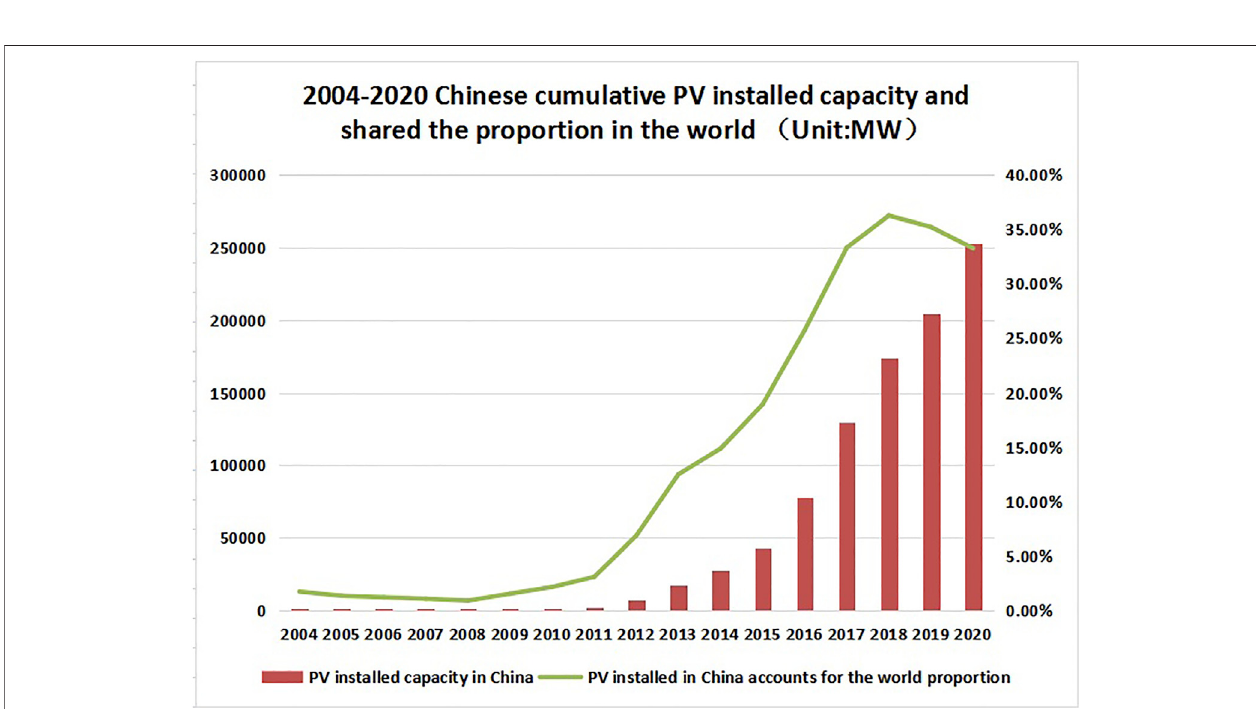
FIGURE 2 | Installed photovoltaic powers in China and its proportion in the world from 2004 to 2020 (unit: MW).